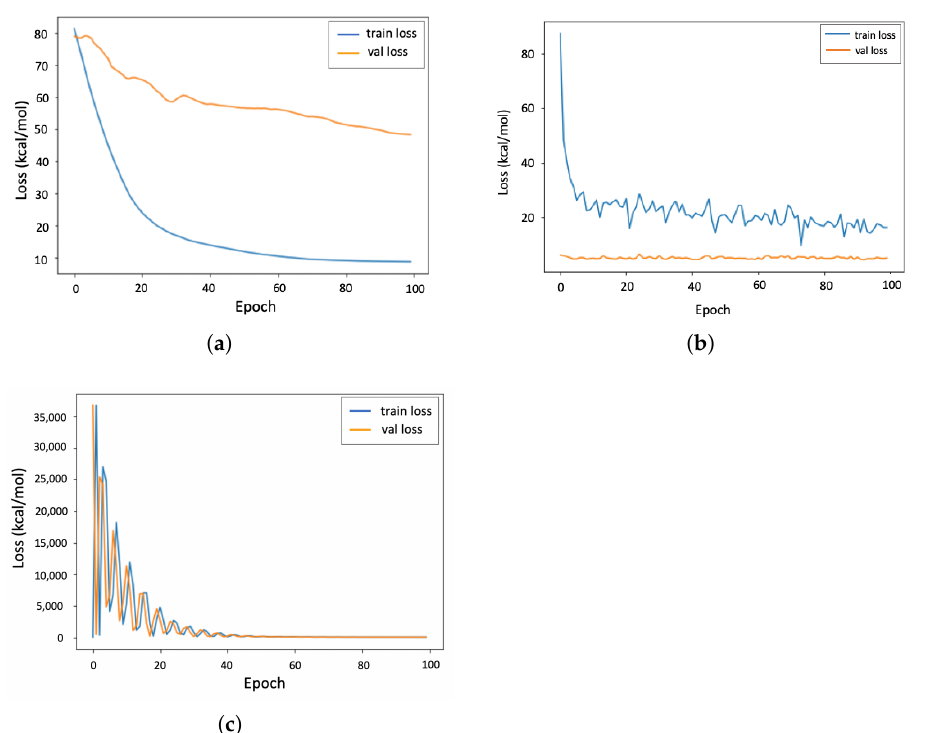
Figure 3. Validation loss (val loss) and training loss (train loss) per epoch for GraphConv, Atom- icConv (data-driven) and PGNN (hybrid) models on the PDBbind dataset. ( a ) GraphConv model; ( b ) AtomicConv model; ( c ) PGNN model.